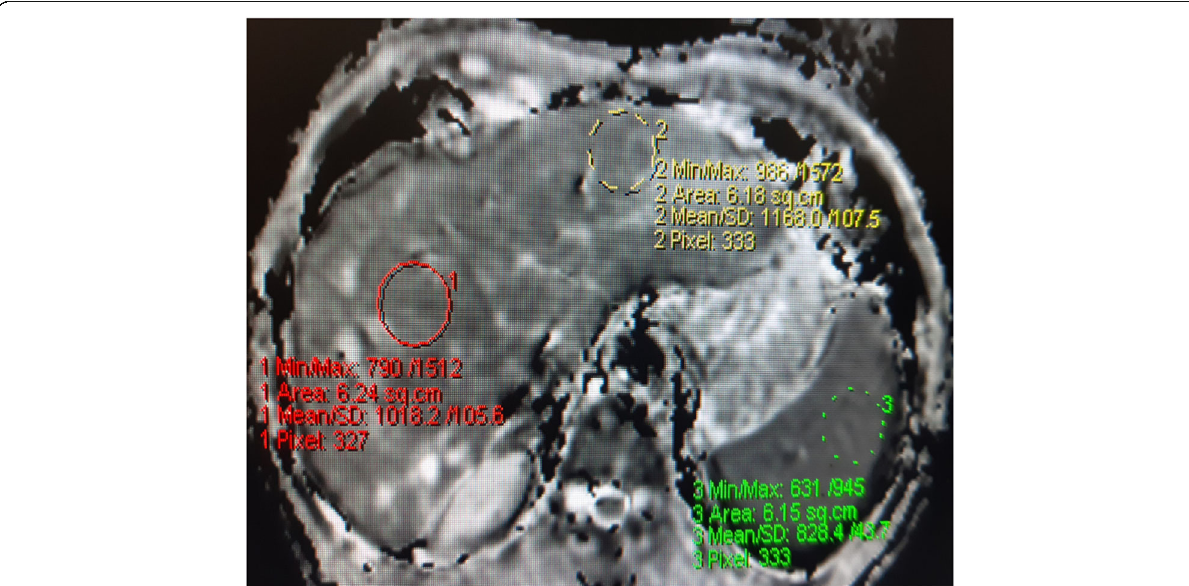
Fig. 4 DW-MR ( b = 800) image and ADC map of the liver and the spleen for a case of F4 stage with HCC [mean liver ADC value = 1093.5 mm 2 /s, mean spleen ADC value = 868.4 mm 2 /s, and liver/spleen ADC =